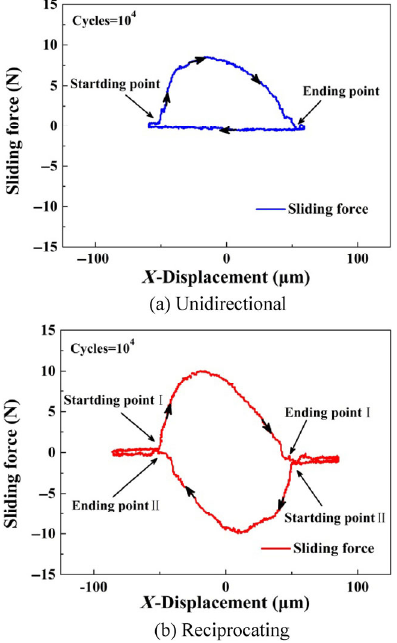
Fig. 11 Sliding force with x -displacement in unidirectional and reciprocating tests mode, cycles=10 4 .